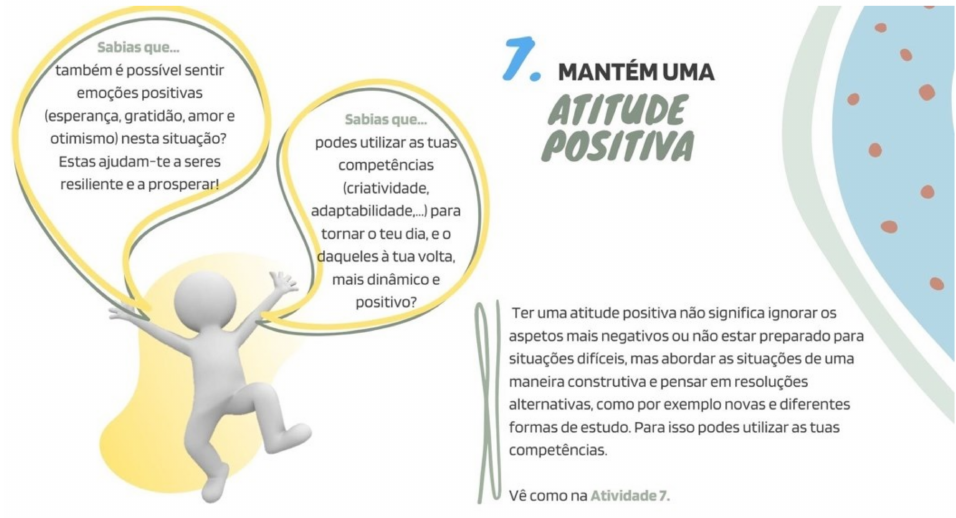
Figure 2. Example of informative contents for a specific strategy (activity 7: “keep a positive